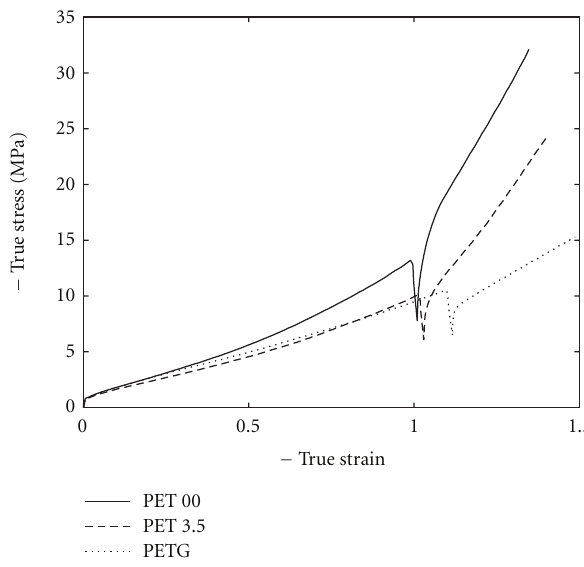
Figure 10: Material comparison, plane strain compression at 90 ◦ C and 0.1/s, and hold at −